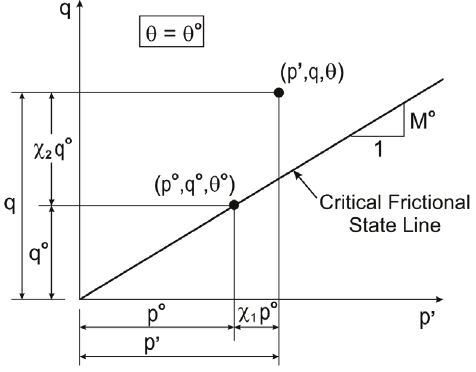
Fig. 2. Reference and current states in the q – p 